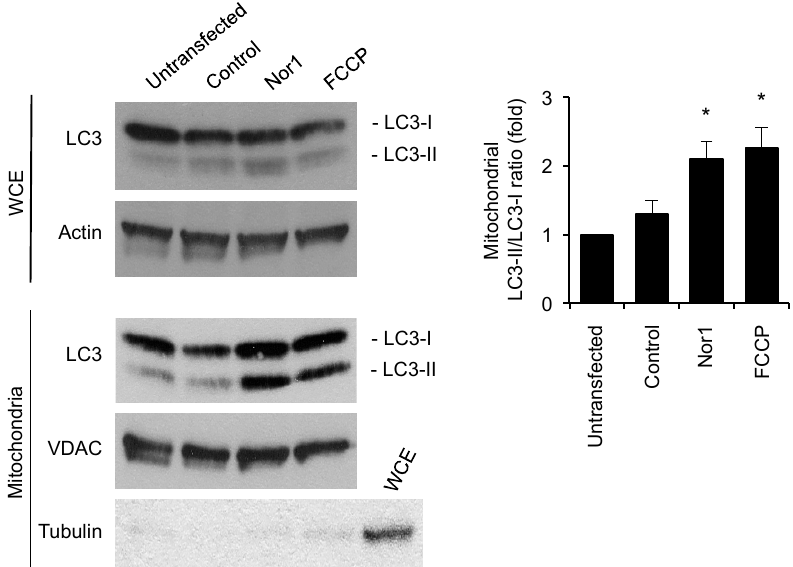
Figure 5. Nor1 increases the conversion of LC3 in beta cells. Representative Western blot images of LC3-I and -II in whole-cell extracts (WCEs) or mitochondrial fractions of untransfected INS832/13 cells, or cells transfected with Nor1-Flag and a control flag vector. FCCP was used as positive control. Actin, tubulin, and VDAC were used to demonstrate equal loading and assess the purity of mitochondrial fractions. The graph shows densitometry analysis of the mitochondrial LC3-I/LC3-II ratios. Results are mean ± SEM of three independent experiments, * p < 0.05 versus control vector.